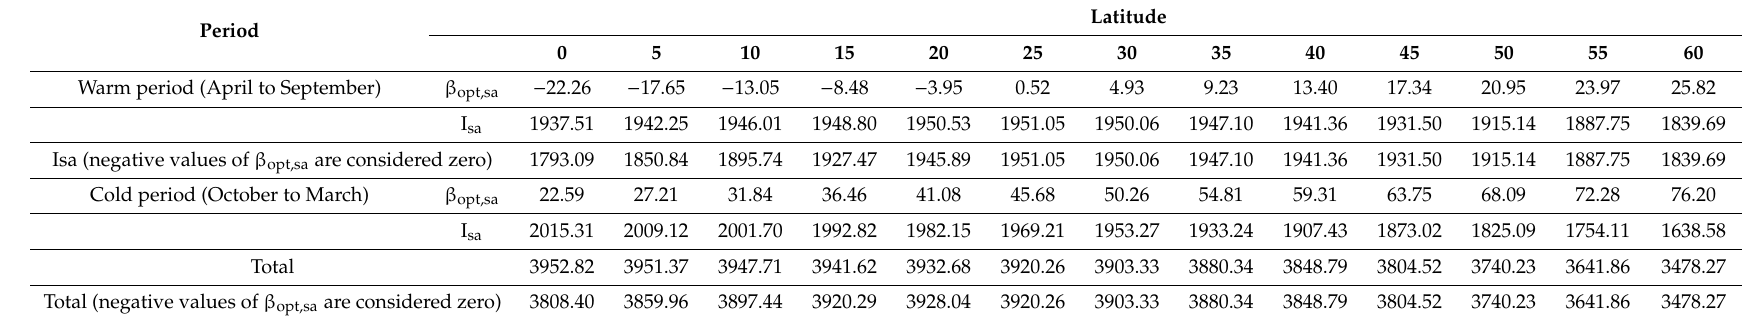
Table 10. The semi-annual optimum tilt angle β opt,sa and extraterrestrial radiation I sa in kWh / m 2 for di ff erent latitudes.